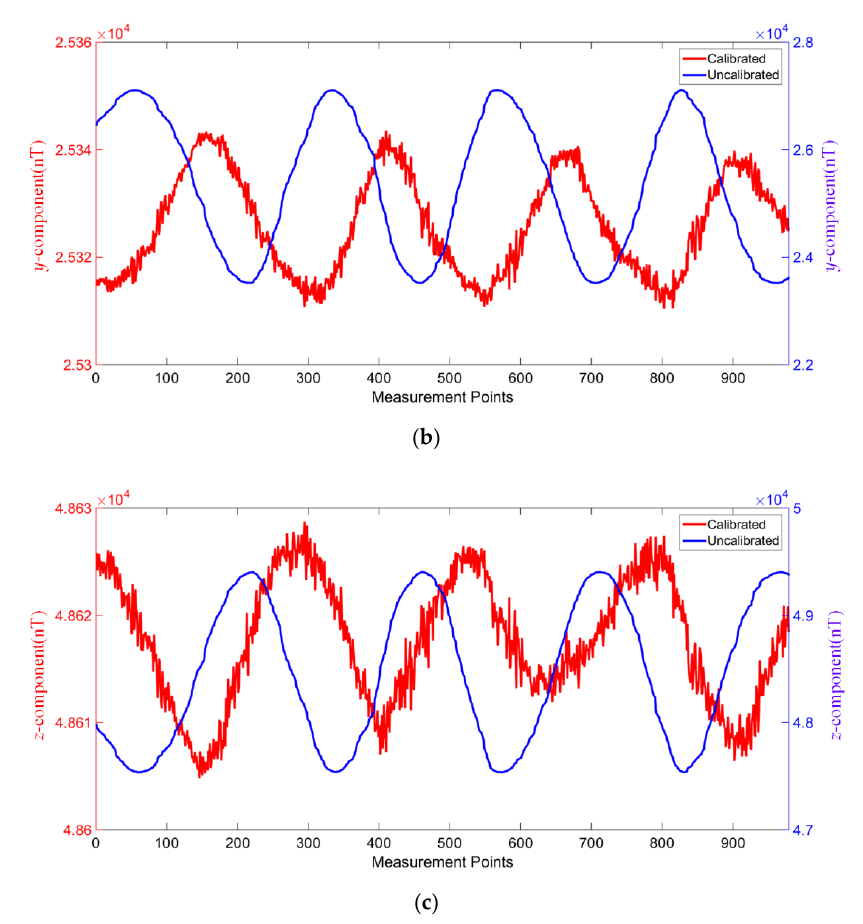
Figure 8. The calibration results. ( a ) The x component; ( b ) The y component; ( c ) The z component.